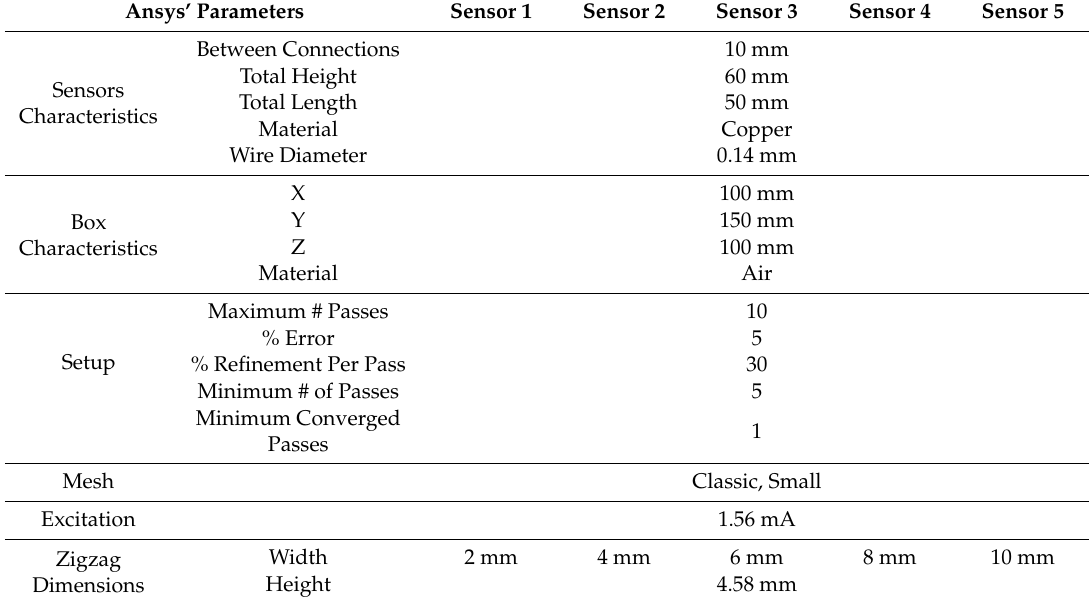
Table 1. Parameters and zigzag characteristics used to simulate 5 single loop inductive textile sensors in Ansys. Values appearing between dashed lines indicate that the same value was used in all simulations.